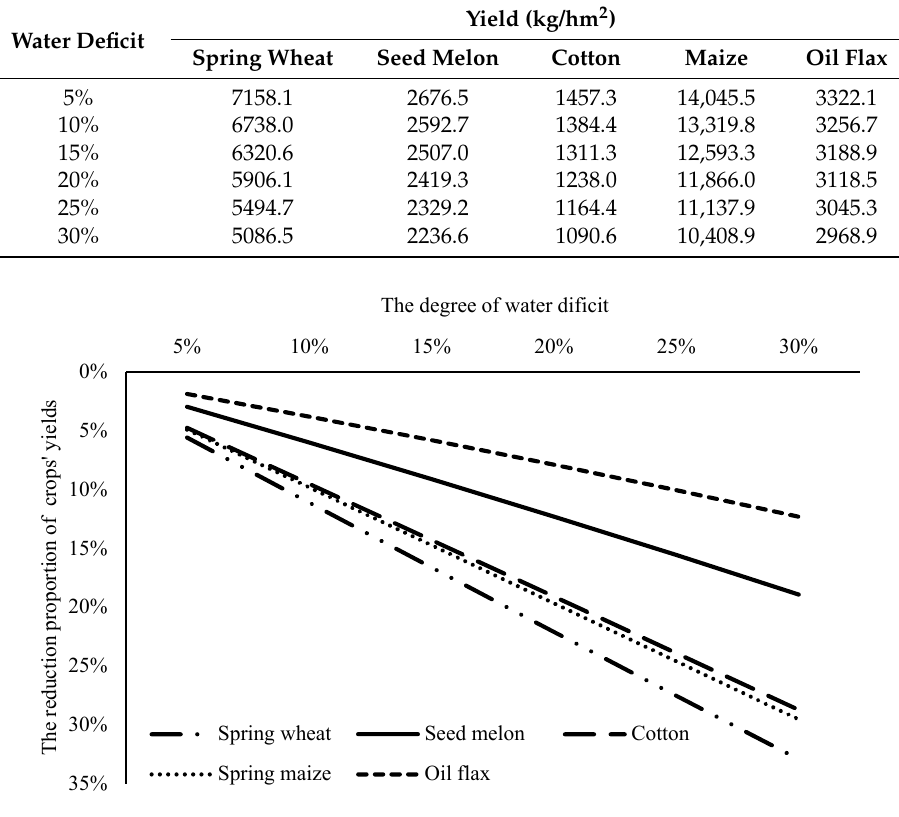
Figure 9. The relations between the reduction of crop yields and the degree of water deficit.